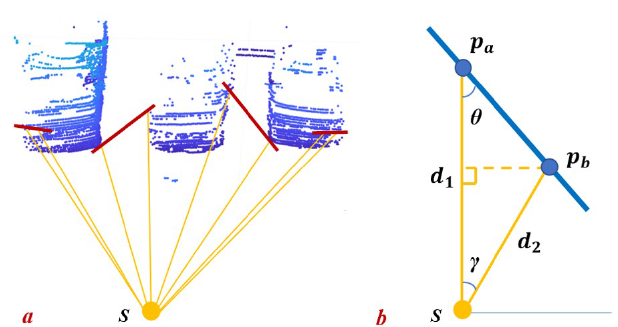
Figure 3. Interpretation of geometry constraint for segmentation. ( a ): three parking cars and laser beams from sensor S. The red line represents the line spawned by two adjacent points. ( b ): geometric abstraction of ( a ). p a and p b represent two adjacent points.